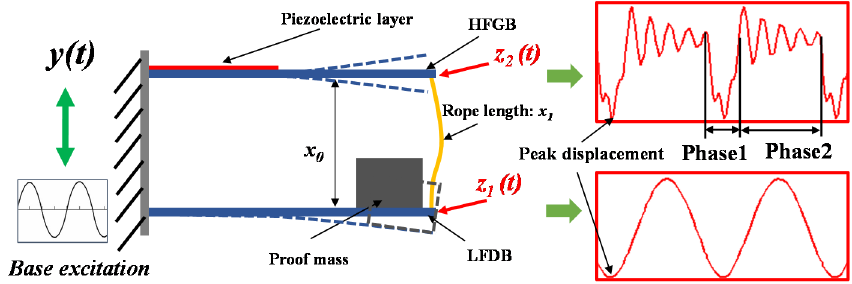
Figure 2. Schematic of the proposed PVEH.